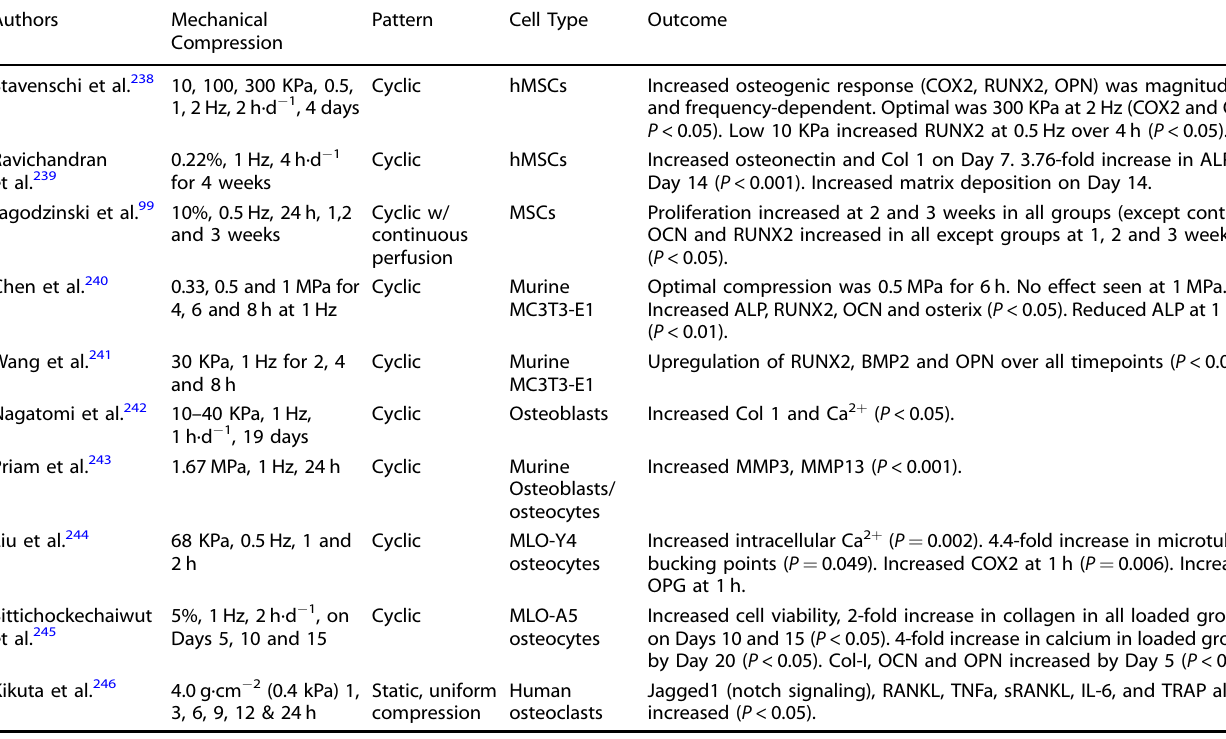
Table 3. Hydrostatic compression Authors Mechanical Compression